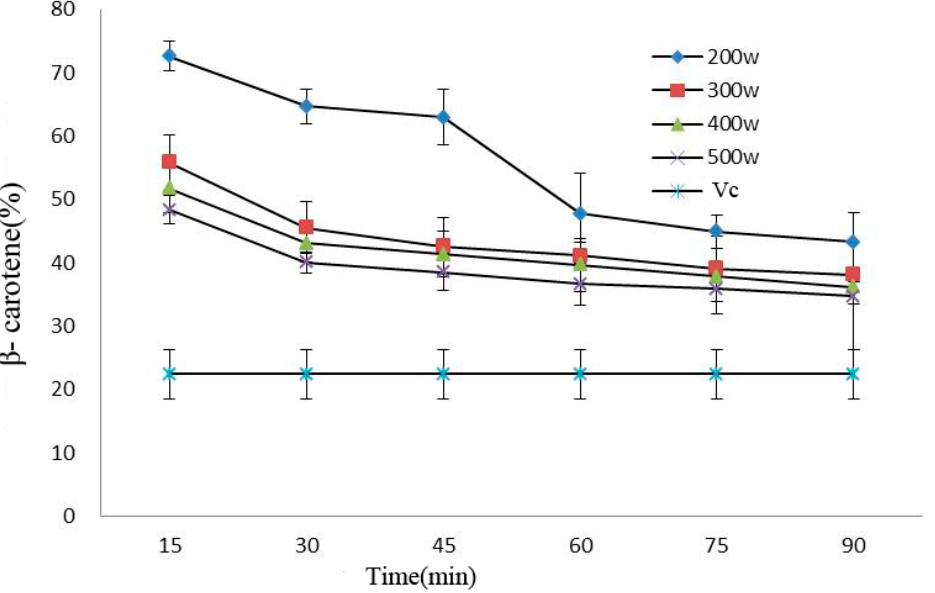
Figure 6. Effect of power ultrasound on the antioxidant activities of Cy-3-glu as measured by β -carotene ( n = 3).